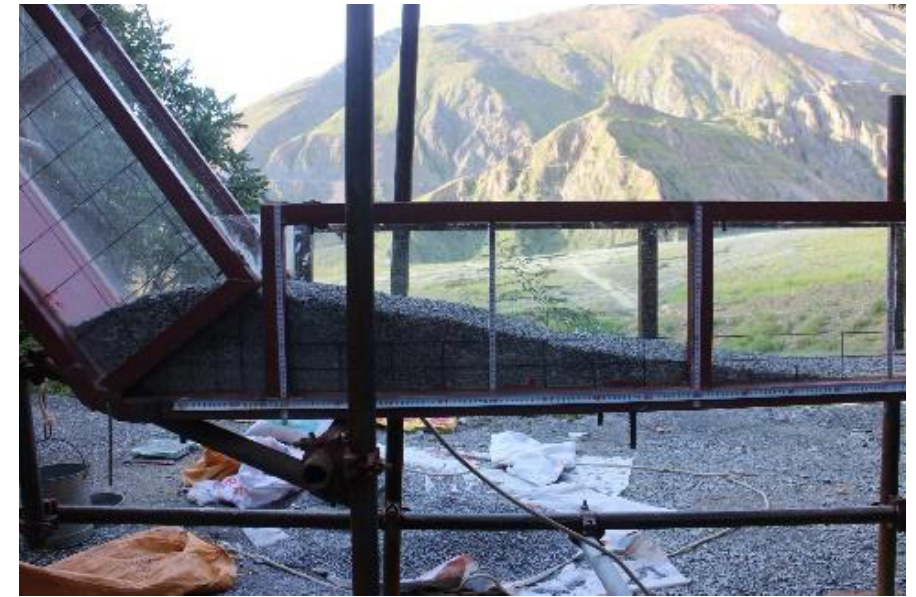
Figure 16. Final deposition after the granular flow for two types of material (coarse and